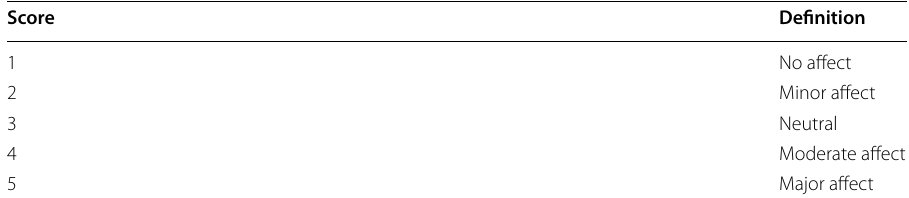
Table 1 Definition of the scale used in the